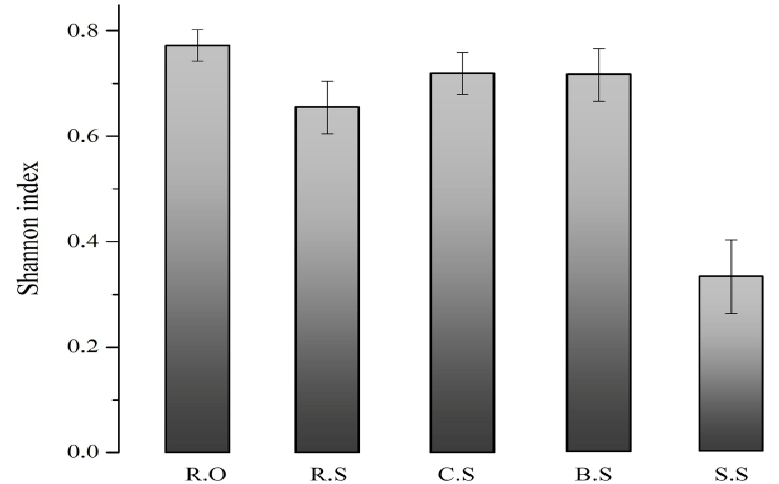
Figure 5. Diversity of GCs in Class 1 integrons in each sample. R.O—agriculture effluent site, R.S—rice field site, C.S—citrus field site, B.S—banana site, S.S—sugarcane site. The bars from left to right show the samples sites. From left to right, the most diverse site in terms of GCs was R.O, and the least diverse was S.S.